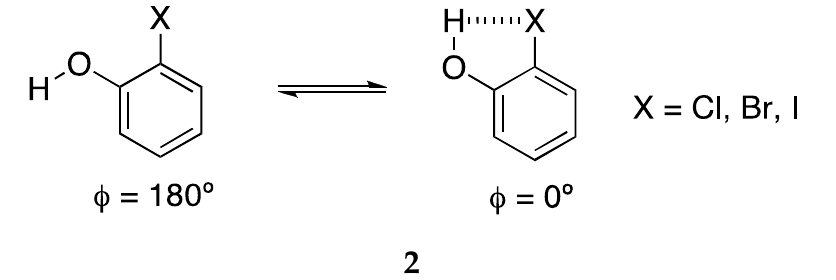
Scheme 1. Schematic description of 2,6-bis(4-ethynylpyridinyl)-4-fluoroaniline interacting with anions.